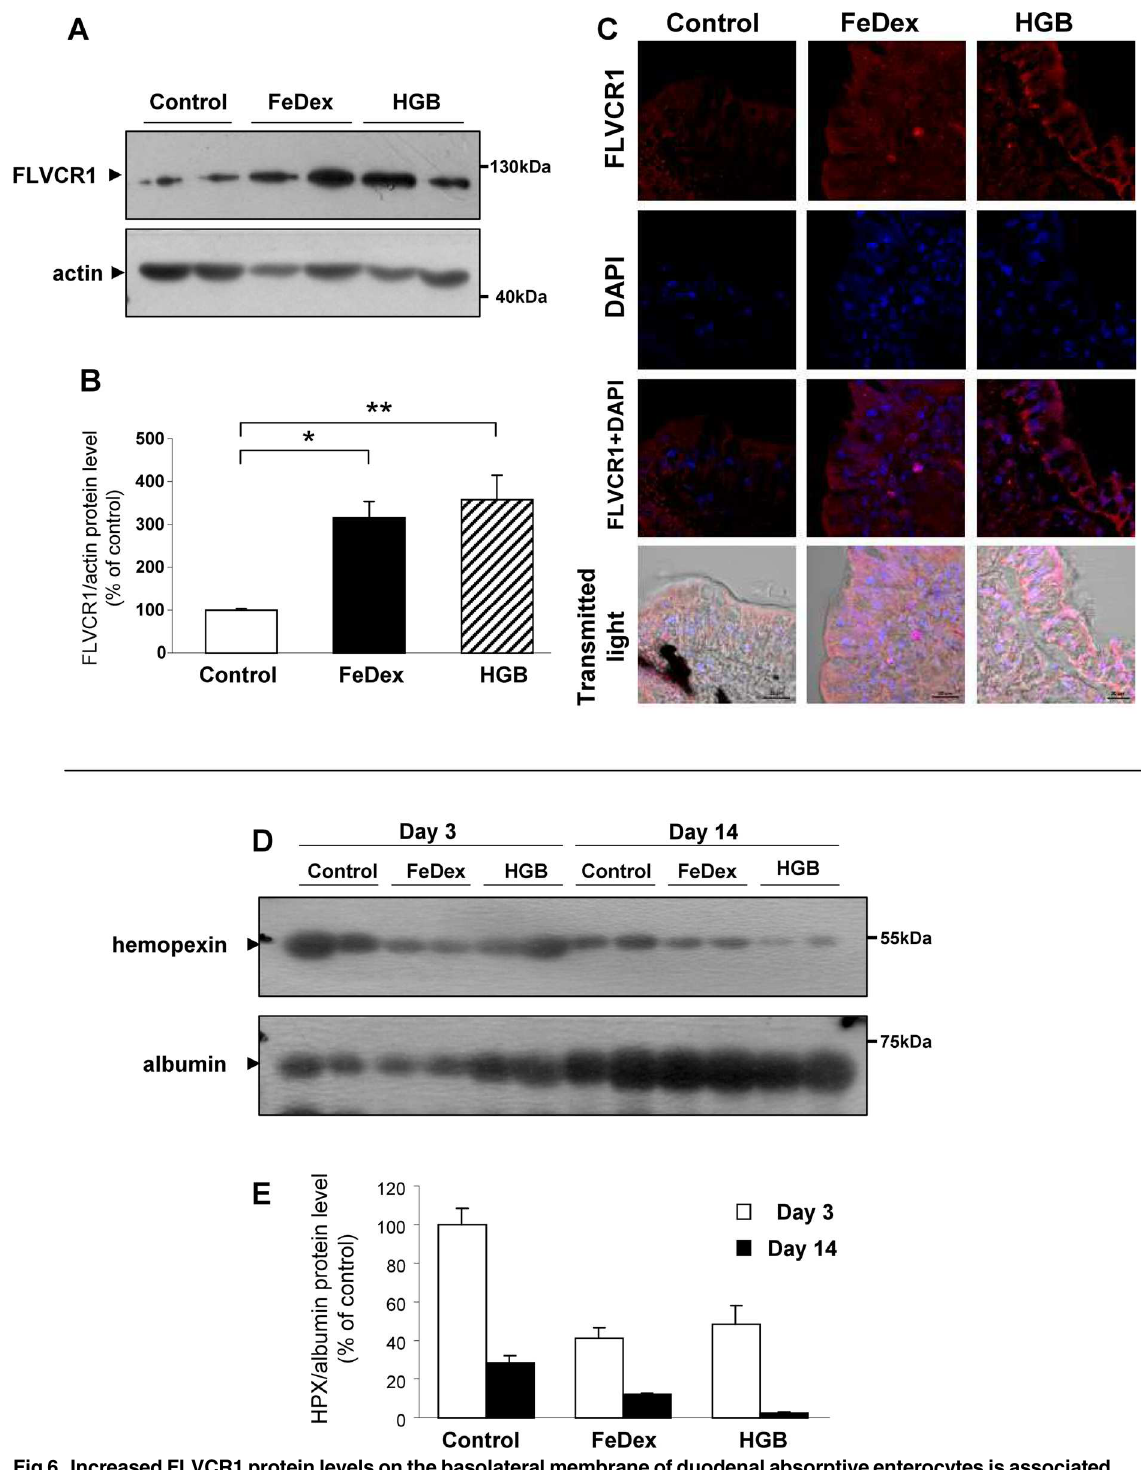
Fig 6. Increased FLVCR1 protein levels on the basolateral membraneof duodenal absorptive enterocytes is associated with decreasedblood plasma hemopexin (Hpx) levels in hemoglobin-supplemented piglets. (A and B) Western blot analysis of FLVCR1 protein levels in membranefractions preparedfrom duodenalscrapings.A representative immunoblot is shown (A) . Immunolabelled FLVCR1 bandsfrom blots performed on scrapingsisolatedfrom 6 pigletswere quantified using a MolecularImager (Bio-Rad),and FLVCR1 protein levels (means ± S.D.) are plotted in arbitrary units (B) . (C) Immunofluorescent stainingof FLVCR1 in